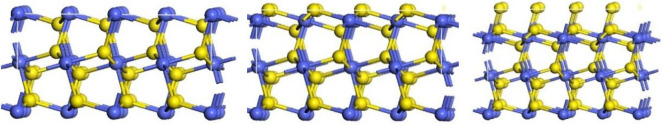
Different terminations of the CoS2 (200) surface.